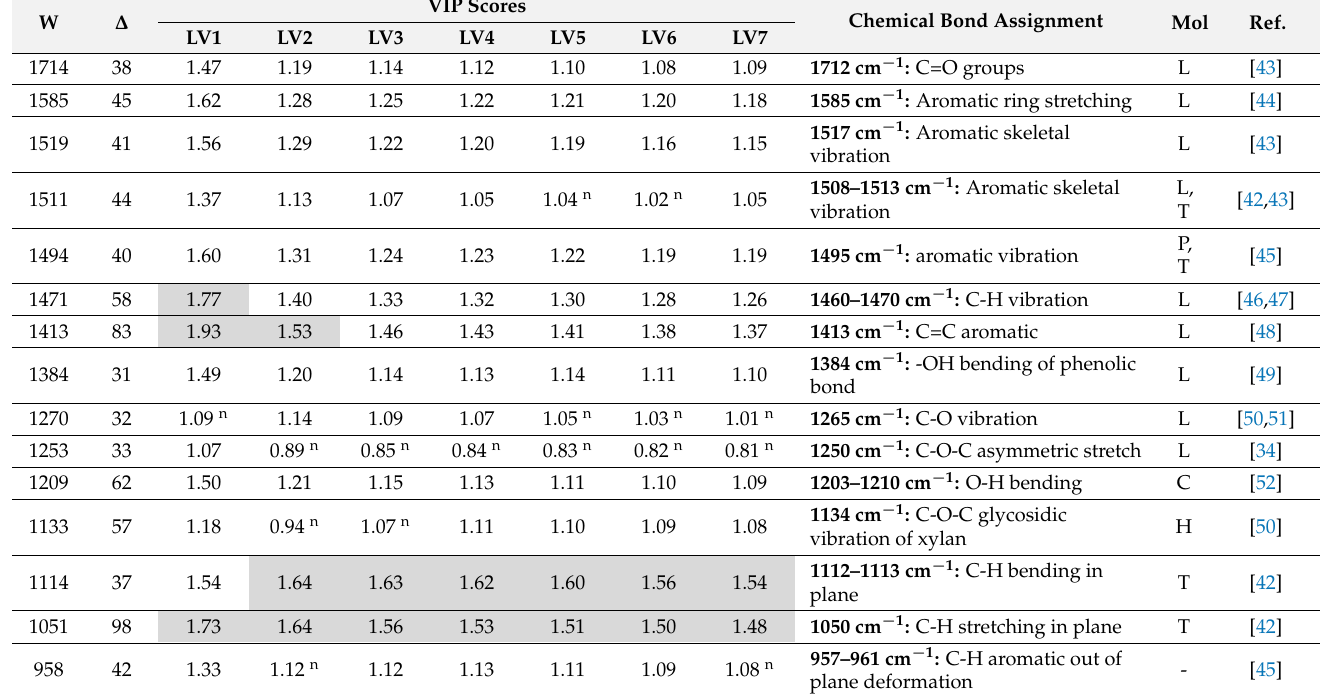
Table 5. Wavenumbers (W), expressed in cm − 1 , that present 15 large peak differences ( × 10 − 3 ) between average species spectrum ( ∆ ); Mean VIP scores from of PLS-DA model, shaded scores are upper to the 95th percentile of vip score within the LV, scores with n are not significantly higher than 1 according to the confidence interval from the cross-validation process; Bond: chemical bond assignement to the wavenumber; Mol corresponds to the molecular class in which the chemical bonds are found (L = Lignin, H = Hemicellulose, C = Cellulose, P = Polyphenol, T = Tannin); Ref. corresponds to references that mention the bond assignment. VIP Scores